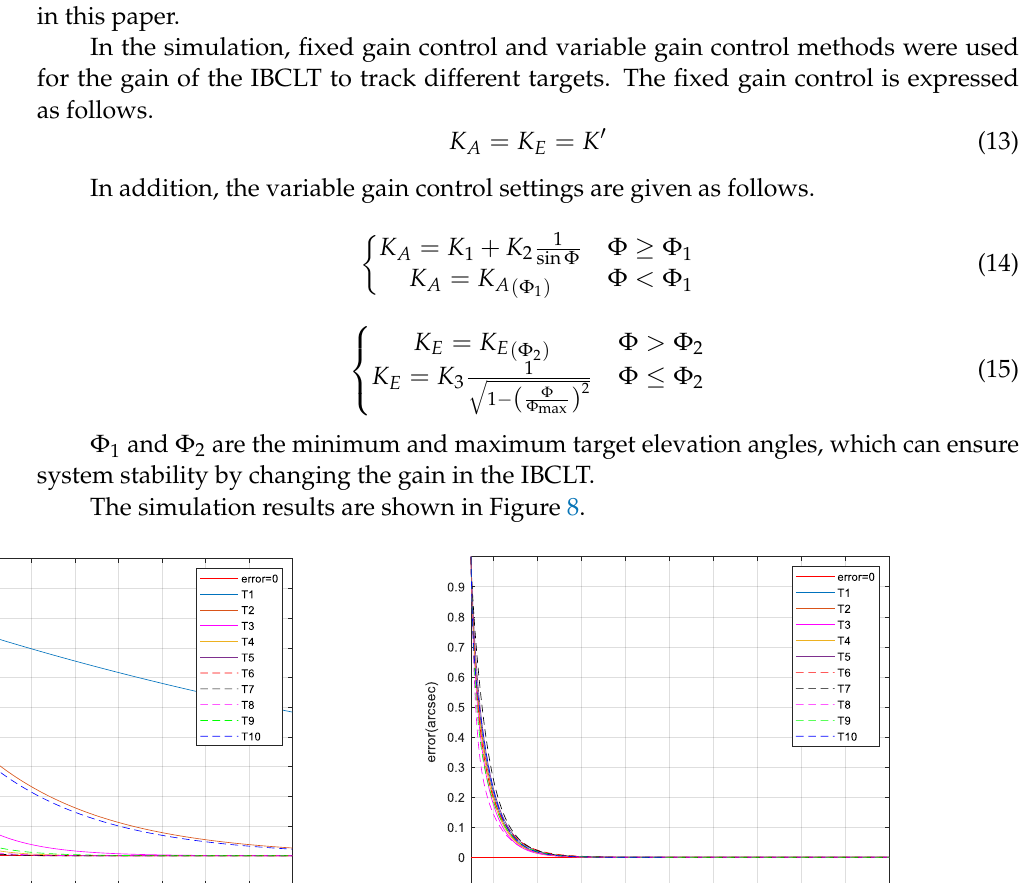
( b ) tracking error controlled by variable gain.